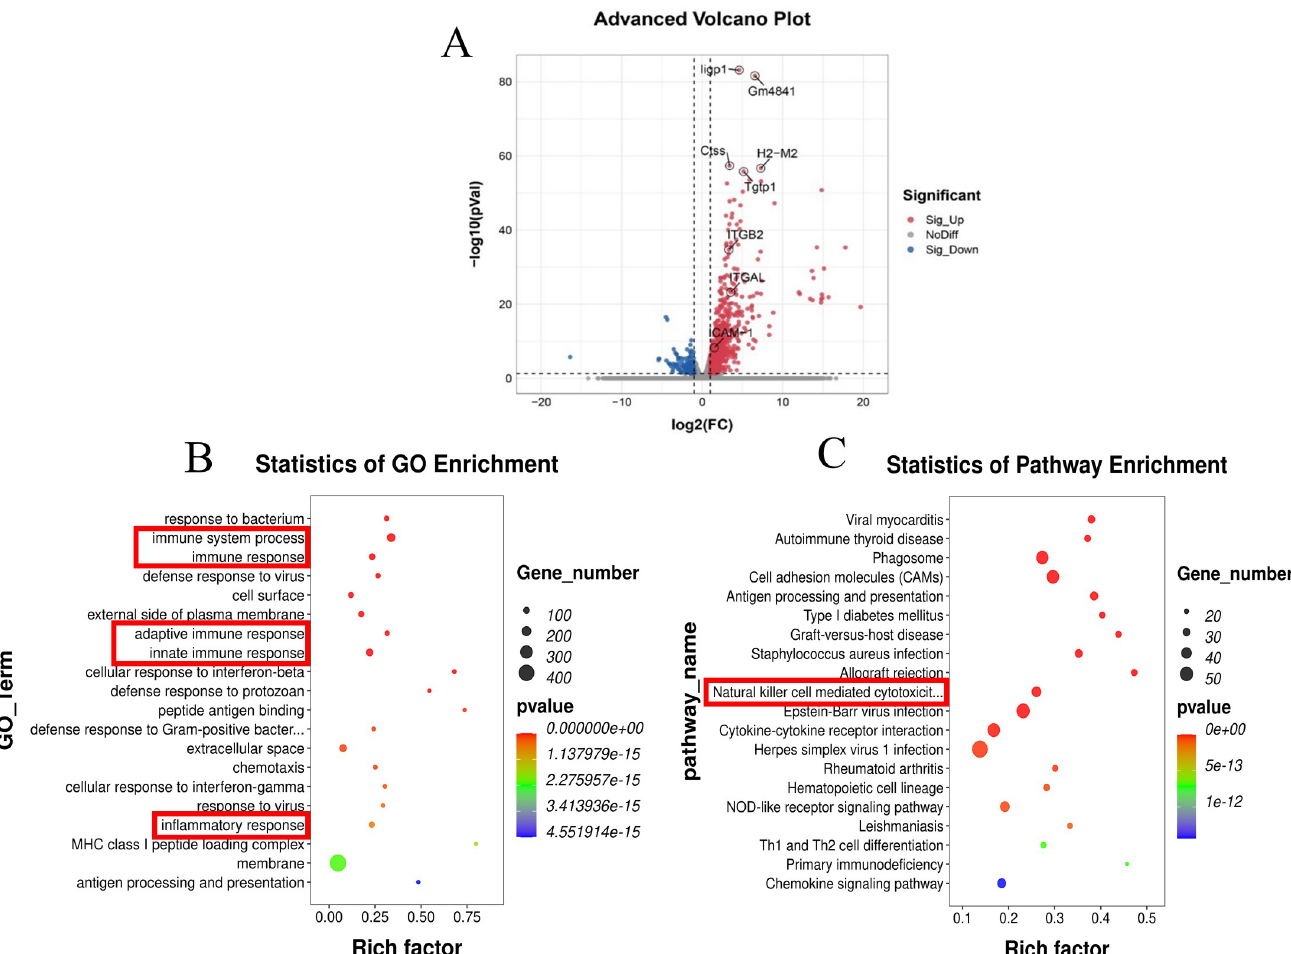
Fig 2. mRNA sequencing and regulatory gene analysis at Day 30 after TgCtwh6 infection. (A) Volcano plots showing Log2(Fold Change) differences versus– Log10(False Discovery Rate) for indicated comparisons, using pooled data from each indicated sample type. Genes exhibiting Log2FC > 1 and FDR < 0.1 are colored. Red represents up-regulated significantly differentially expressed genes, blue represents down-regulated significantly differentially expressed genes and grey dots represent non-significant differentially expressed genes. The differentially expressed mRNAs were selected with fold change > 2 or fold change < 0.5 and p value < 0.05 by R package edgeR or DESeq2, and then analysis GO enrichment (B) and KEGG enrichment (C) to the differentially expressed mRNAs.